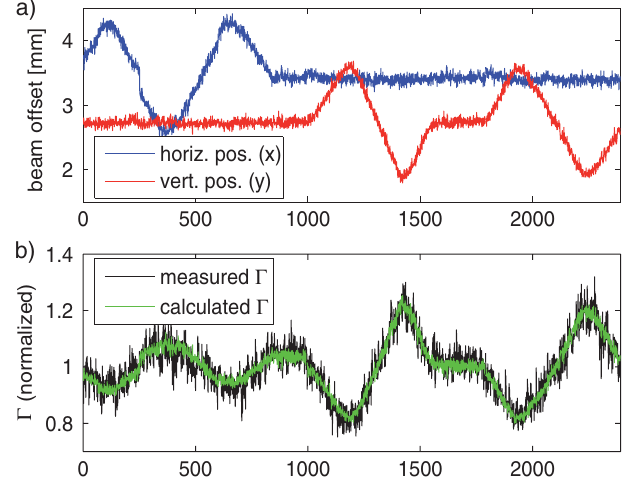
FIG. 18. (Color) (a) Orbit dependence of the phase retardation measured with spectrally resolved detection. x and y are the horizontal and vertical distance between the electron beam orbit and the laser spot on the EO crystal; (b) shows the measured and the calculated peak (cid:1)